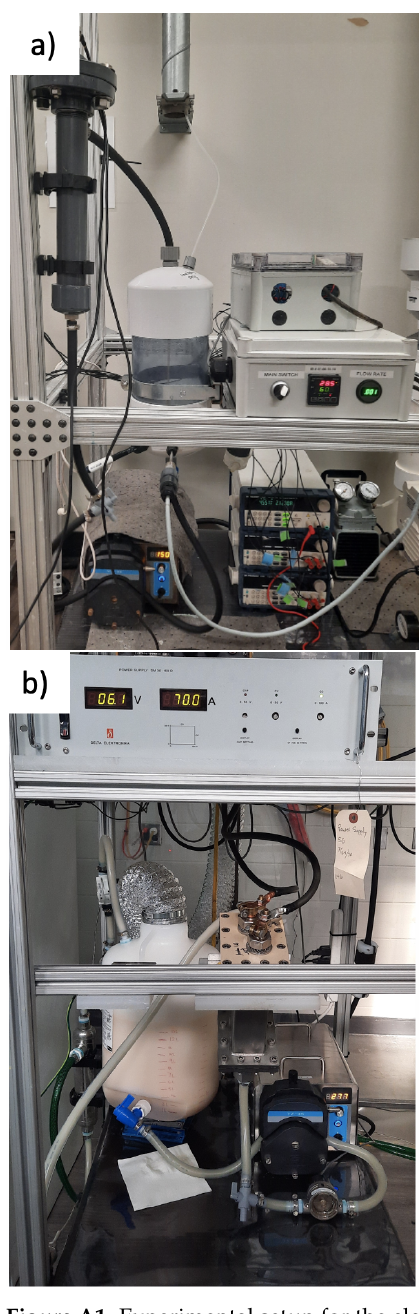
Figure A1. Experimental setup for the electrochemical oxidation of PFAAs from IX still bottoms at the ( a ) laboratory and ( b ) semi-pilot